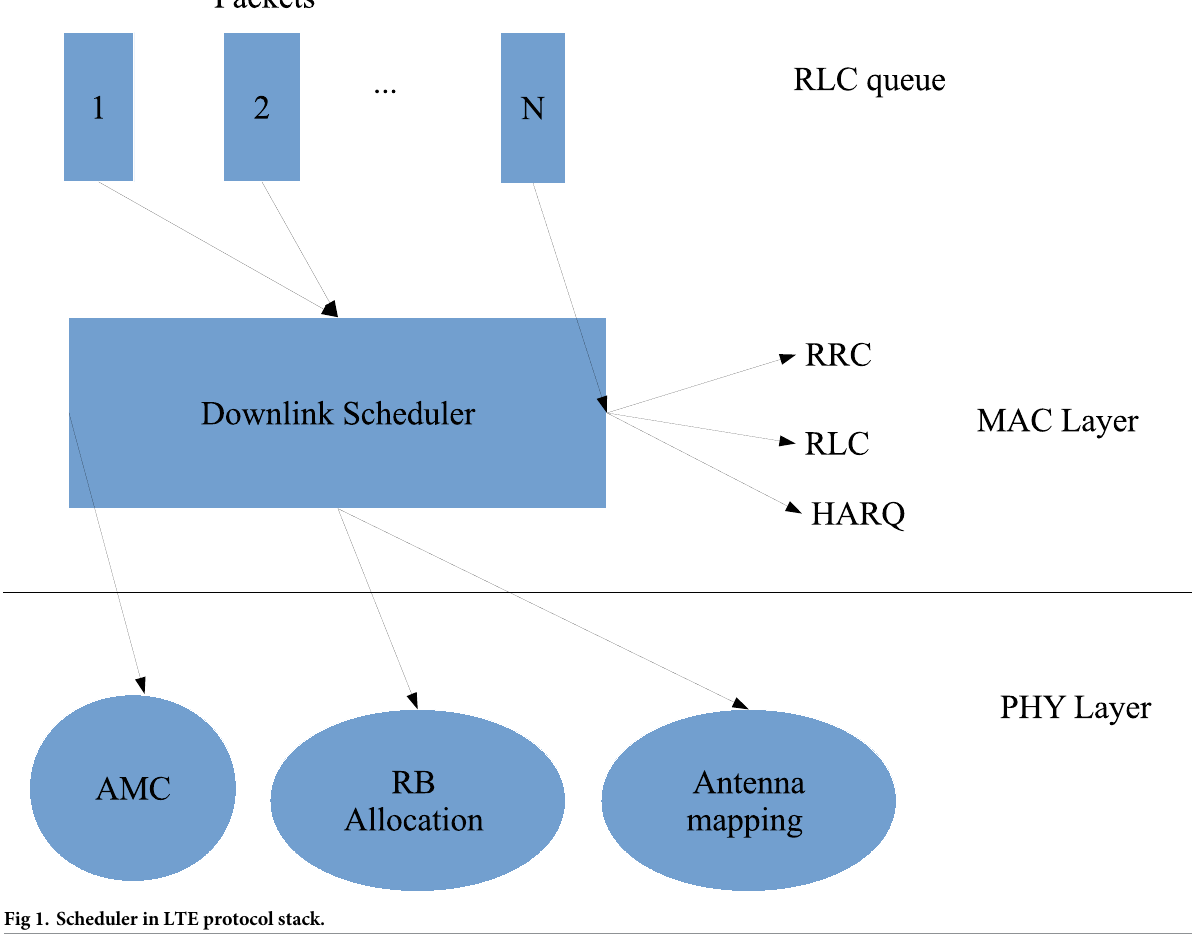
Fig 1. Scheduler in LTE protocol